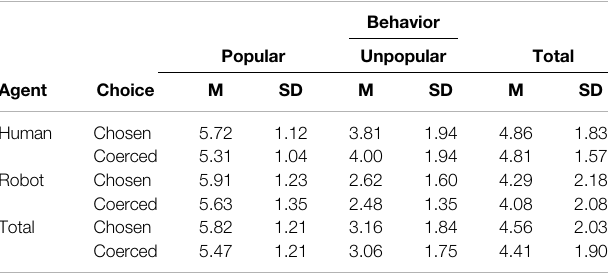
TABLE 1 | Means and standard deviations for attributed attitudes (1 – 7; opposes it:supports